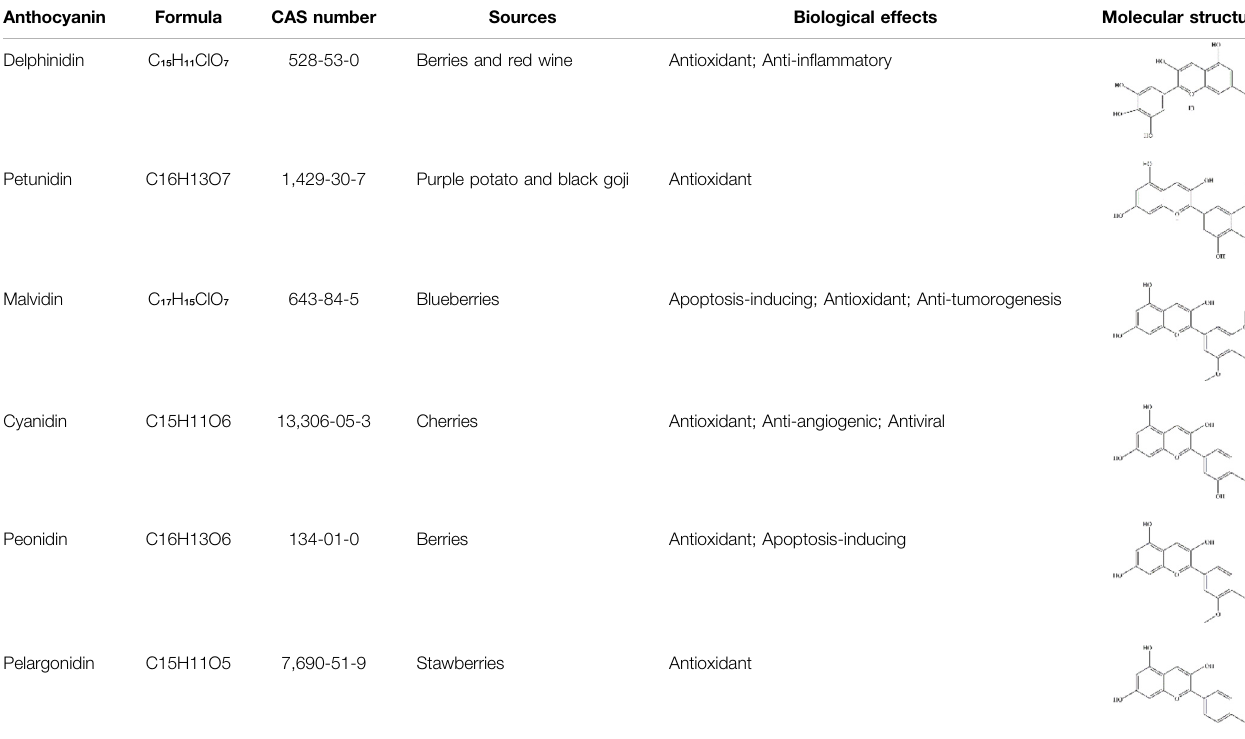
TABLE 2 | The basic information of six major anthocyanins.